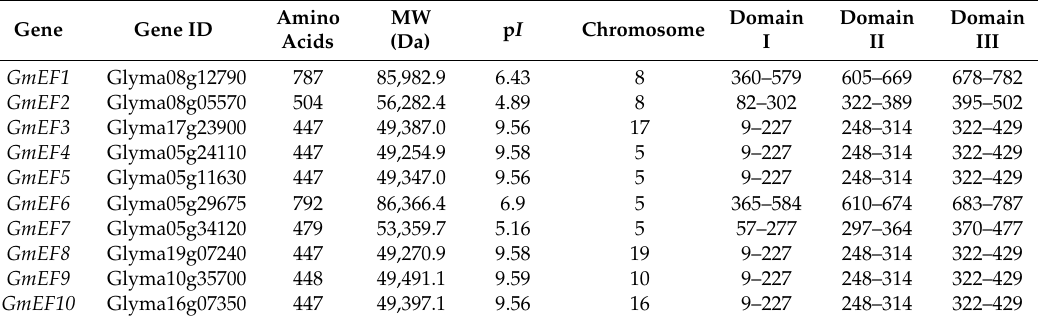
Table 1. Details of the 10 soybean elongation factor 1 α (EF1 α ) proteins, including sequence ID, protein sequence length, predicted molecular weight (MW), predicted isoelectric point (p I ), chromosomal location, and predicted functional